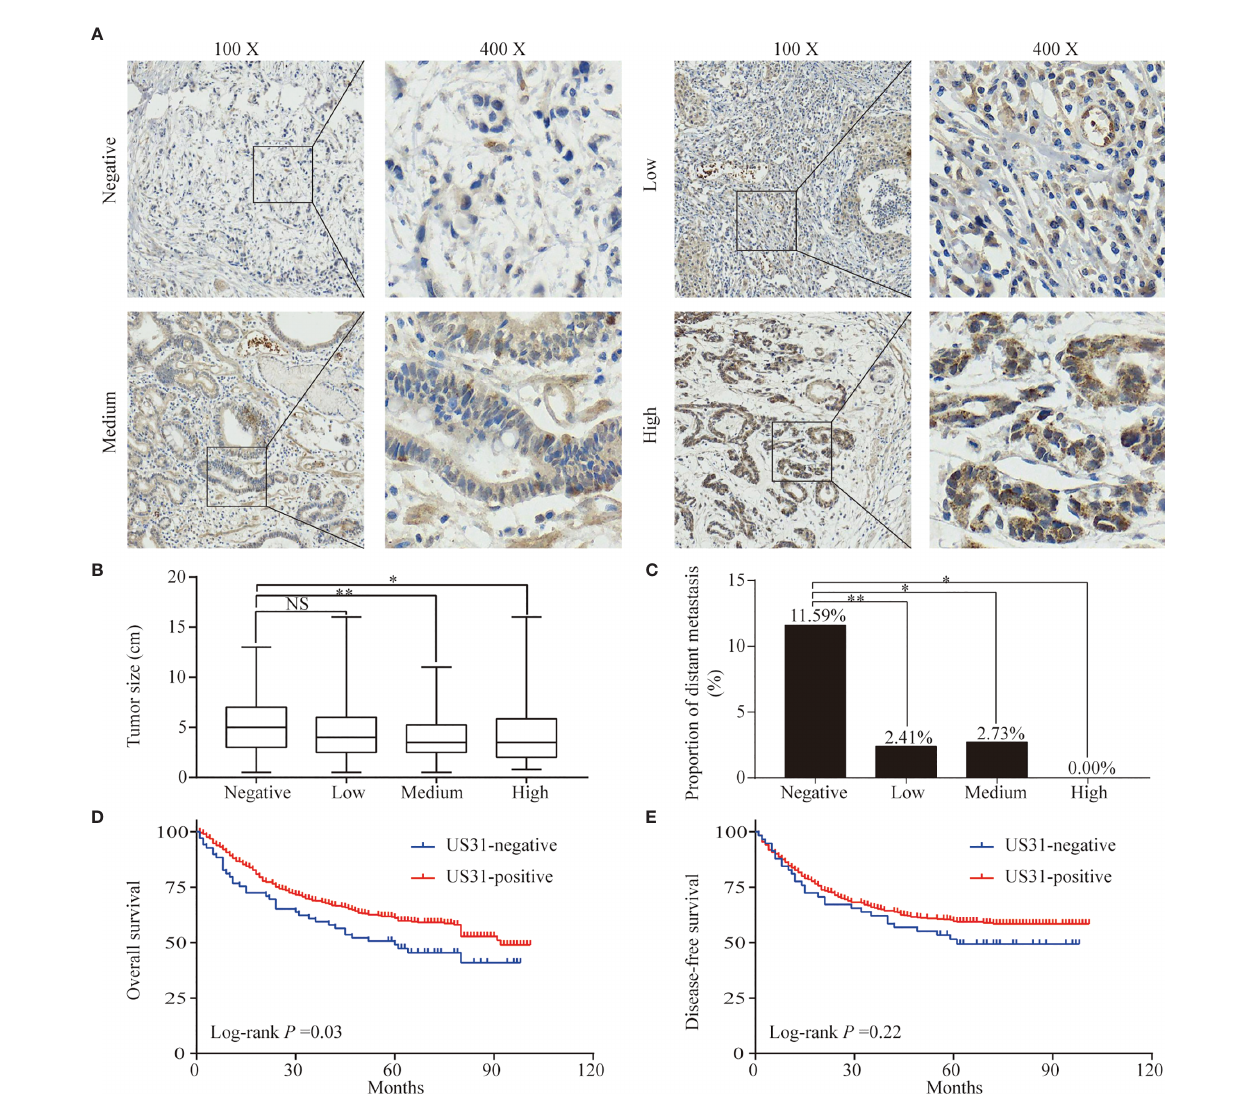
FIGURE 1 | Expression of US31 in gastric cancer (GC) and its impact on prognosis. ( A ) Representative immunohistochemical staining of US31 in GC tissue. Brown indicates positive staining. (B) Correlation between the expression level of US31 and tumor size. (C) Correlation between the expression level of US31 and distant metastasis. (D) Kaplan-Meier curves for overall survival of GC patients with US31 expression. (E) Kaplan-Meier curves for disease-free survival of GC patients with US31 expression. *P < 0.05 and **P < 0.01. ns, no signi fi cance.